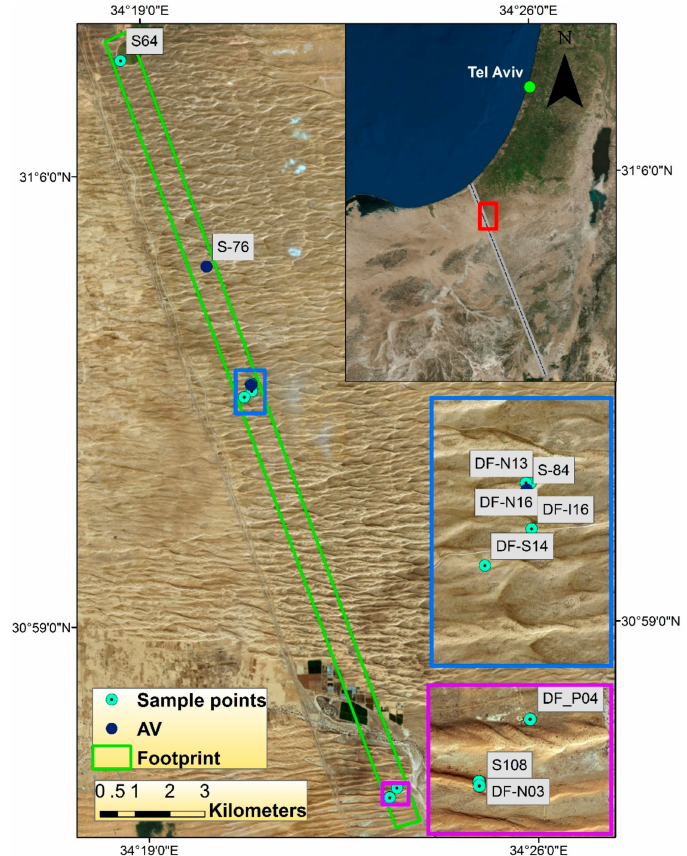
Figure 1. The study area with 10 sample points (cyan), of which 2 points (dark blue) were used for atmospheric validation (AV). The image footprint is marked with green polygone. S symbolizes exposed sand, DF-N symbolizes north-facing slopes, DF-S symbolizes south-facing slopes, and DF-P symbolizes playa. Background image source: Esri, DigitalGlobe, GeoEye, Earthstar Geographics, CNES/Airbus DS, USDA, USGS, AEX, Getmapping, Aerogrid, IGN, IGP, swisstopo, and the